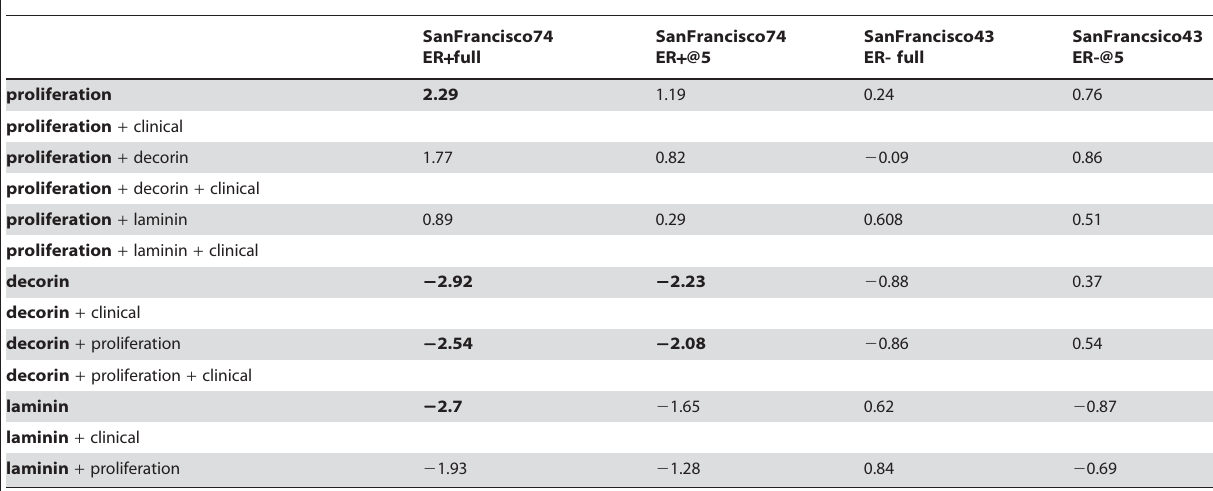
Table 6. Cox proportional hazards models for the SAN FRANCISCO cohort.